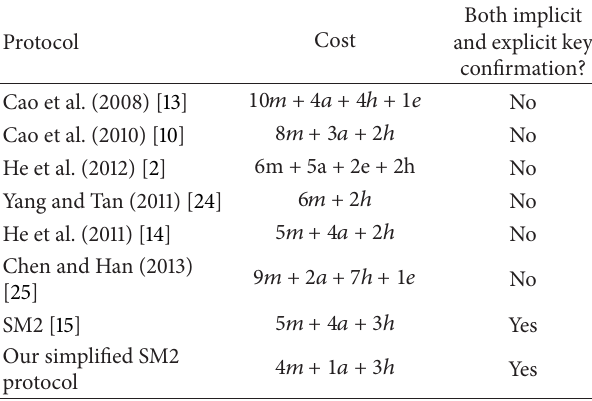
Table 3: Protocol